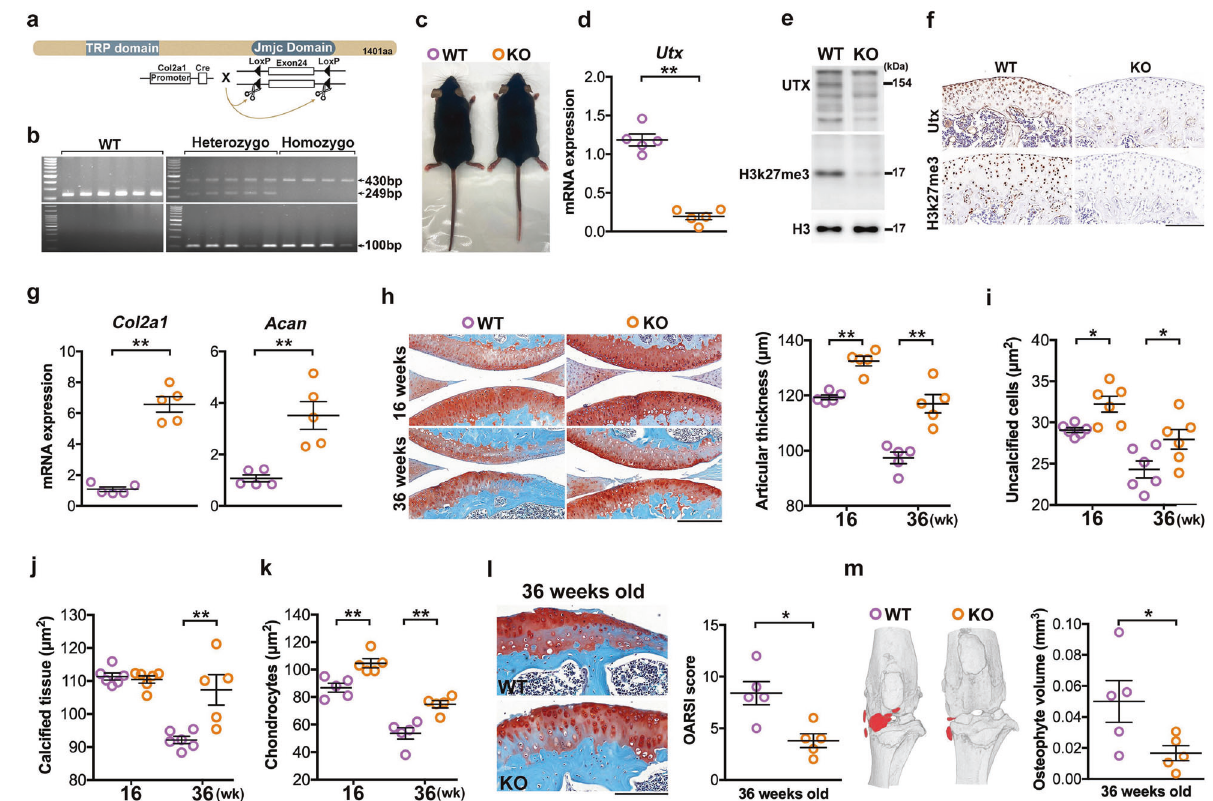
Fig. 3 Utx knockout promoted ECM synthesis and protected articular cartilage integrity. Schematic drawing of the generation of chondrocyte-speci fi c Utx knockout mice; exon 24 of Utx, containing the JmjC domain of the enzyme, was fl oxed and cleavage of these sites resulted in the transcription/translation of inactive Utx. Through mating Utx mice with Col2-Cre mice, its expression is further under control of the cartilage-speci fi c collagen type II gene promoter ( a ). Con fi rmation of proper genotypes of UtxKO and WT mice; heterozygous UtxKO mice carried fl ox constructs corresponding to 430 and 249 bp, whereas homozygous UtxKO mice only expressed amplicons corresponding to 430 bp. Absence of a 100 bp PCR amplicon in WT mice, corresponding to the Cre construct, but presence in UtxKO mice ( b ). Appearance and hair color of UtxKO mice were similar to WT mice ( c ). mRNA expression ( d ) and protein abundance ( e ), respectively, con fi rming the absence of Utx and reduced H3K27me3 levels in UtxKO mice. Very faint Utx and H3K27me3 immunostaining in articular cartilage of KO mice ( f ); scale